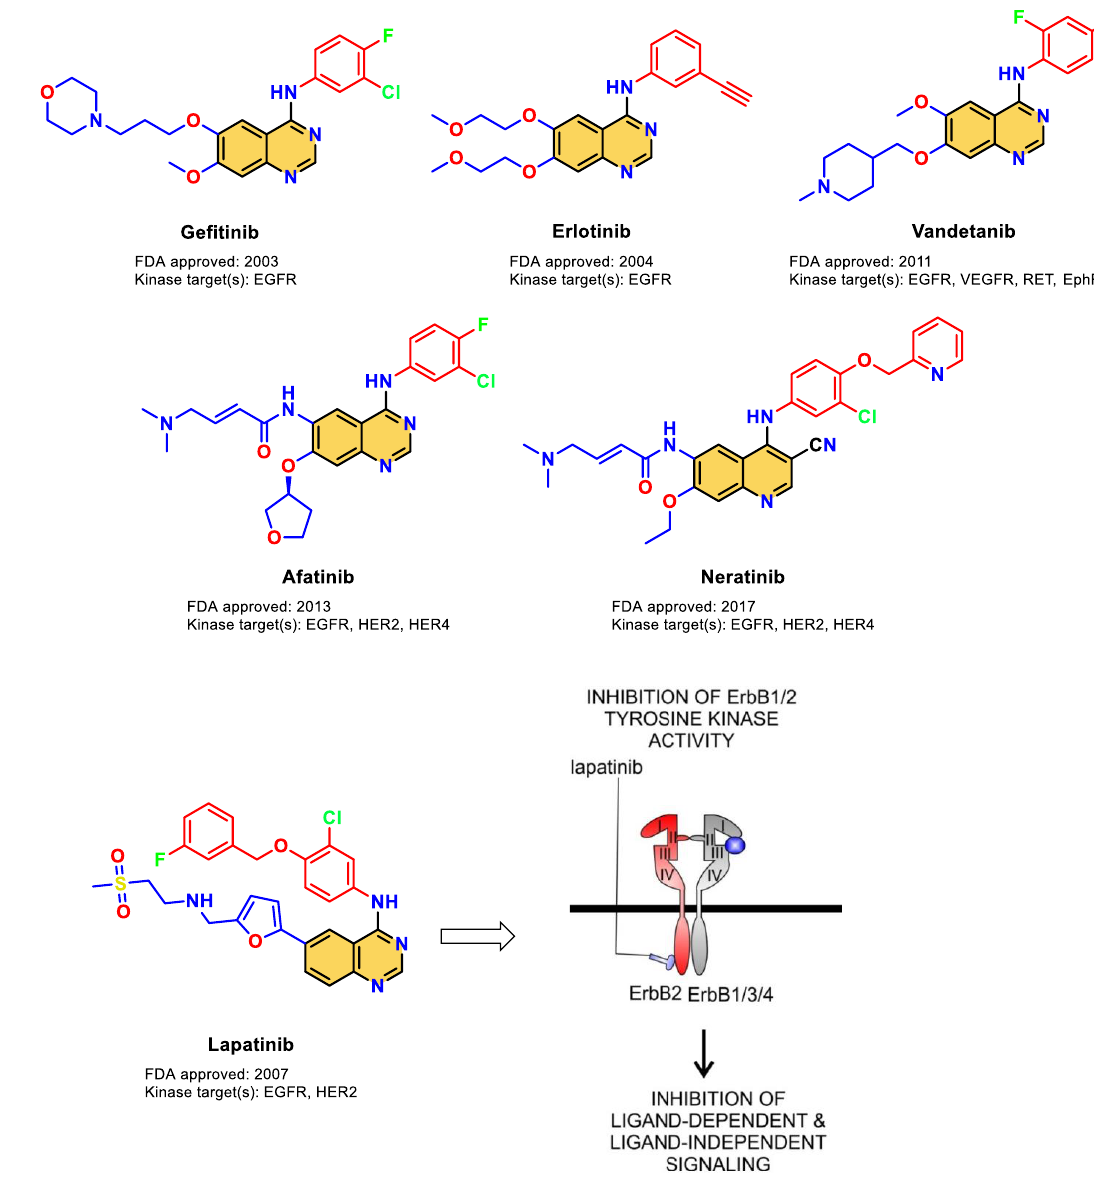
Figure 1. FDA-approved EGFR kinase inhibitors and the mechanism of action of Lapatinib [33].